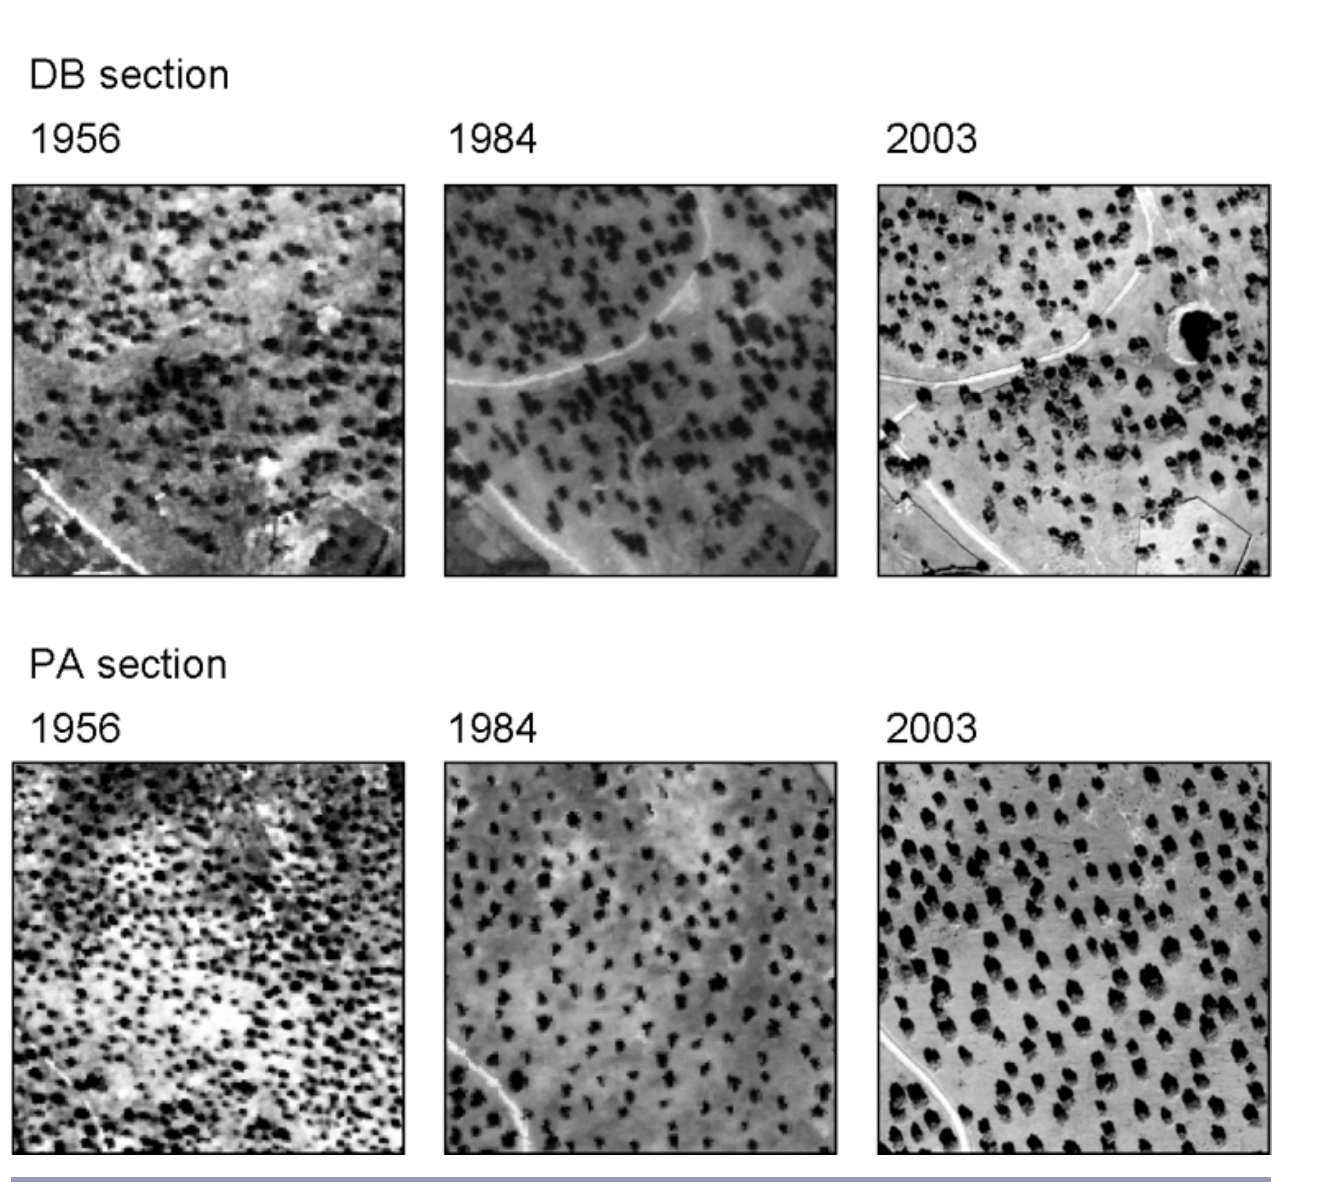
Fig. 3 . Comparison of stand development 1956 (left), 1984 (center), and 2003 (right) of a Dehesa Boyal (DB) section (above) and a Parapuños de Doña María (PA) section